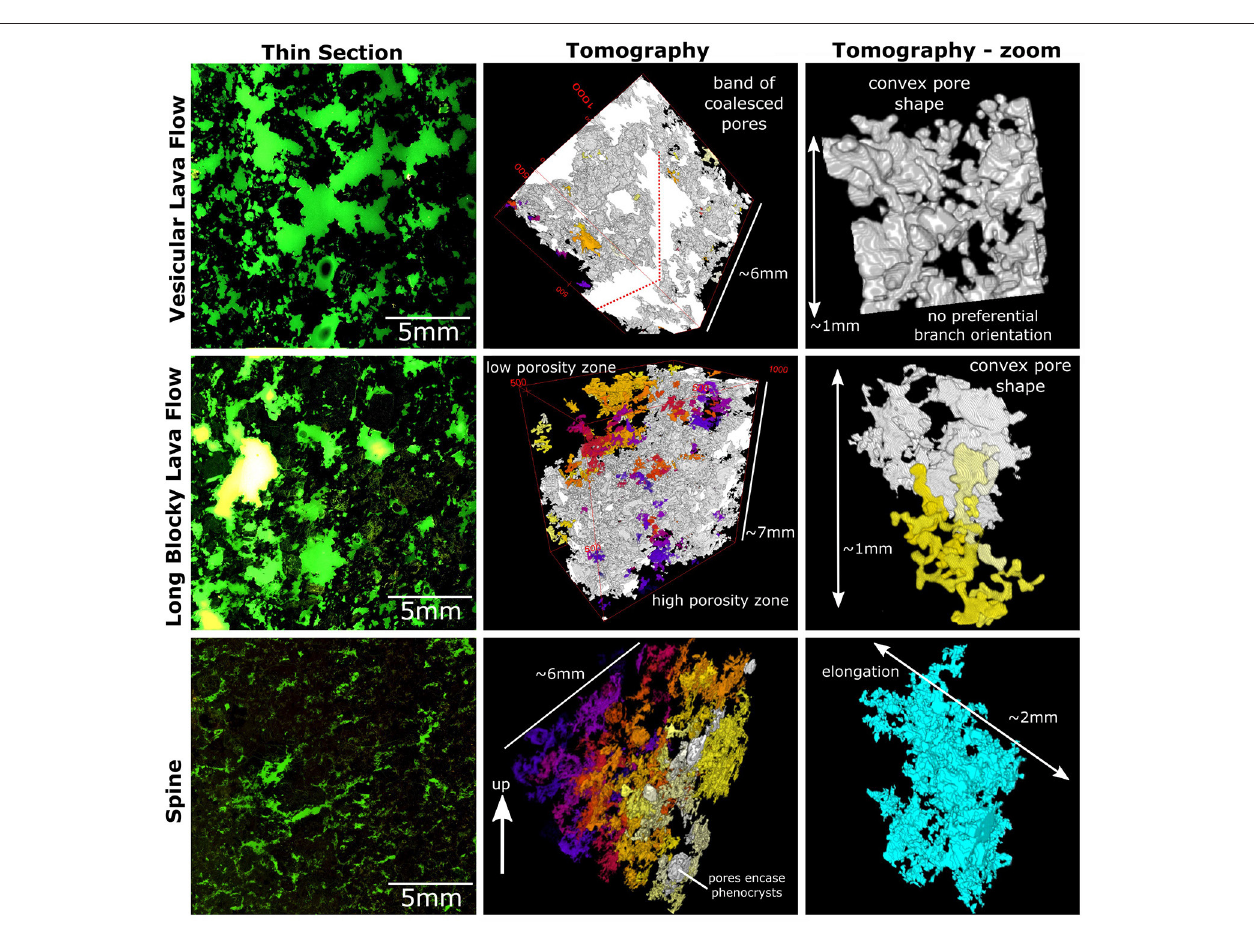
FIGURE 6 | Ultra-violet pictomicrographs and tomography imaging of pores in vesicular and blocky lava flows, and of the dense interior of spines. Different colors in tomography images represent connected pores, and the 100 largest pores are displayed in the images.